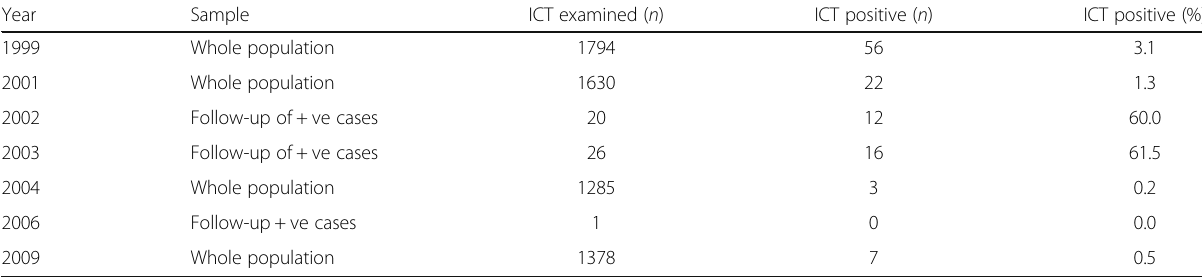
Table 2 Results of filarial blood surveys in Niue under PacELF